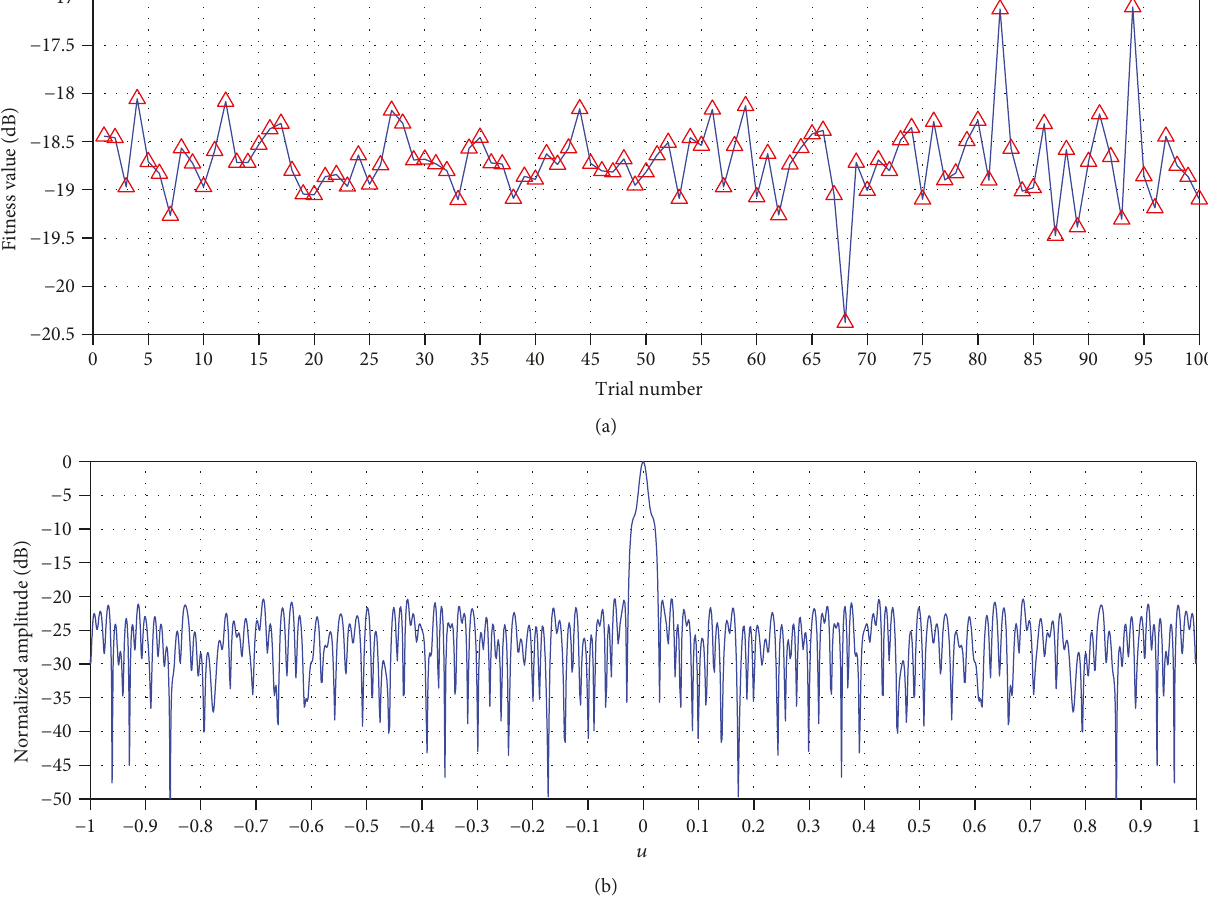
Figure 5: The sparse linear array obtained by the IFT-DE based on an asymmetrical TLA with a fi lling factor of 39%. (a) The convergence curve of the fi tness value. (b) The optimal far- fi eld pattern among 100